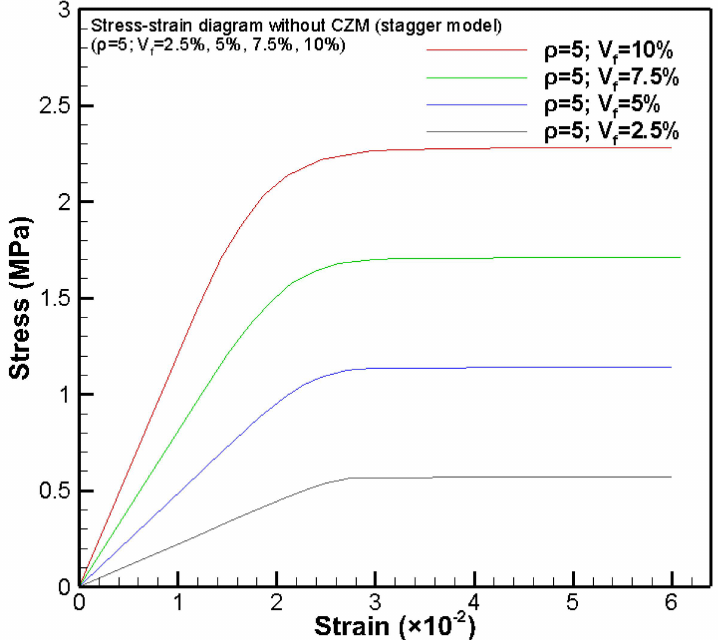
Figure 19. Effective stress-strain diagrams of the PNC (stagger nanoparticle configuration) without CZM at the nanoparticle volume fraction of V f = 2.5%, 5%, 7.5%, and 10%, respectively ( ρ =